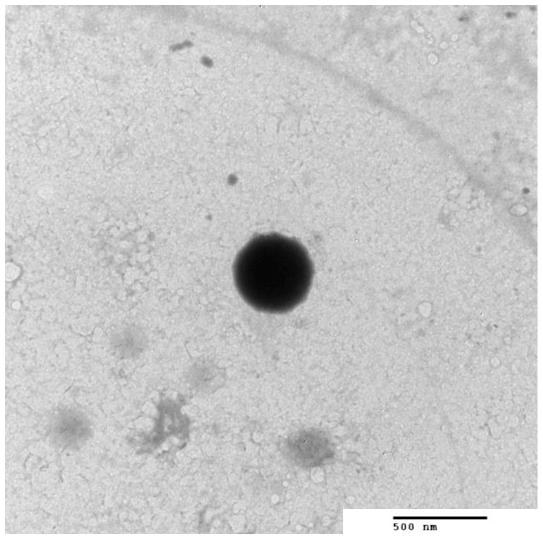
Figure 6. 3:TEM of luteolin-loaded bilosomes (BL4) (150,000× magnification). Figure 6. TEM of luteolin-loaded bilosomes (BL4) (150,000 ×